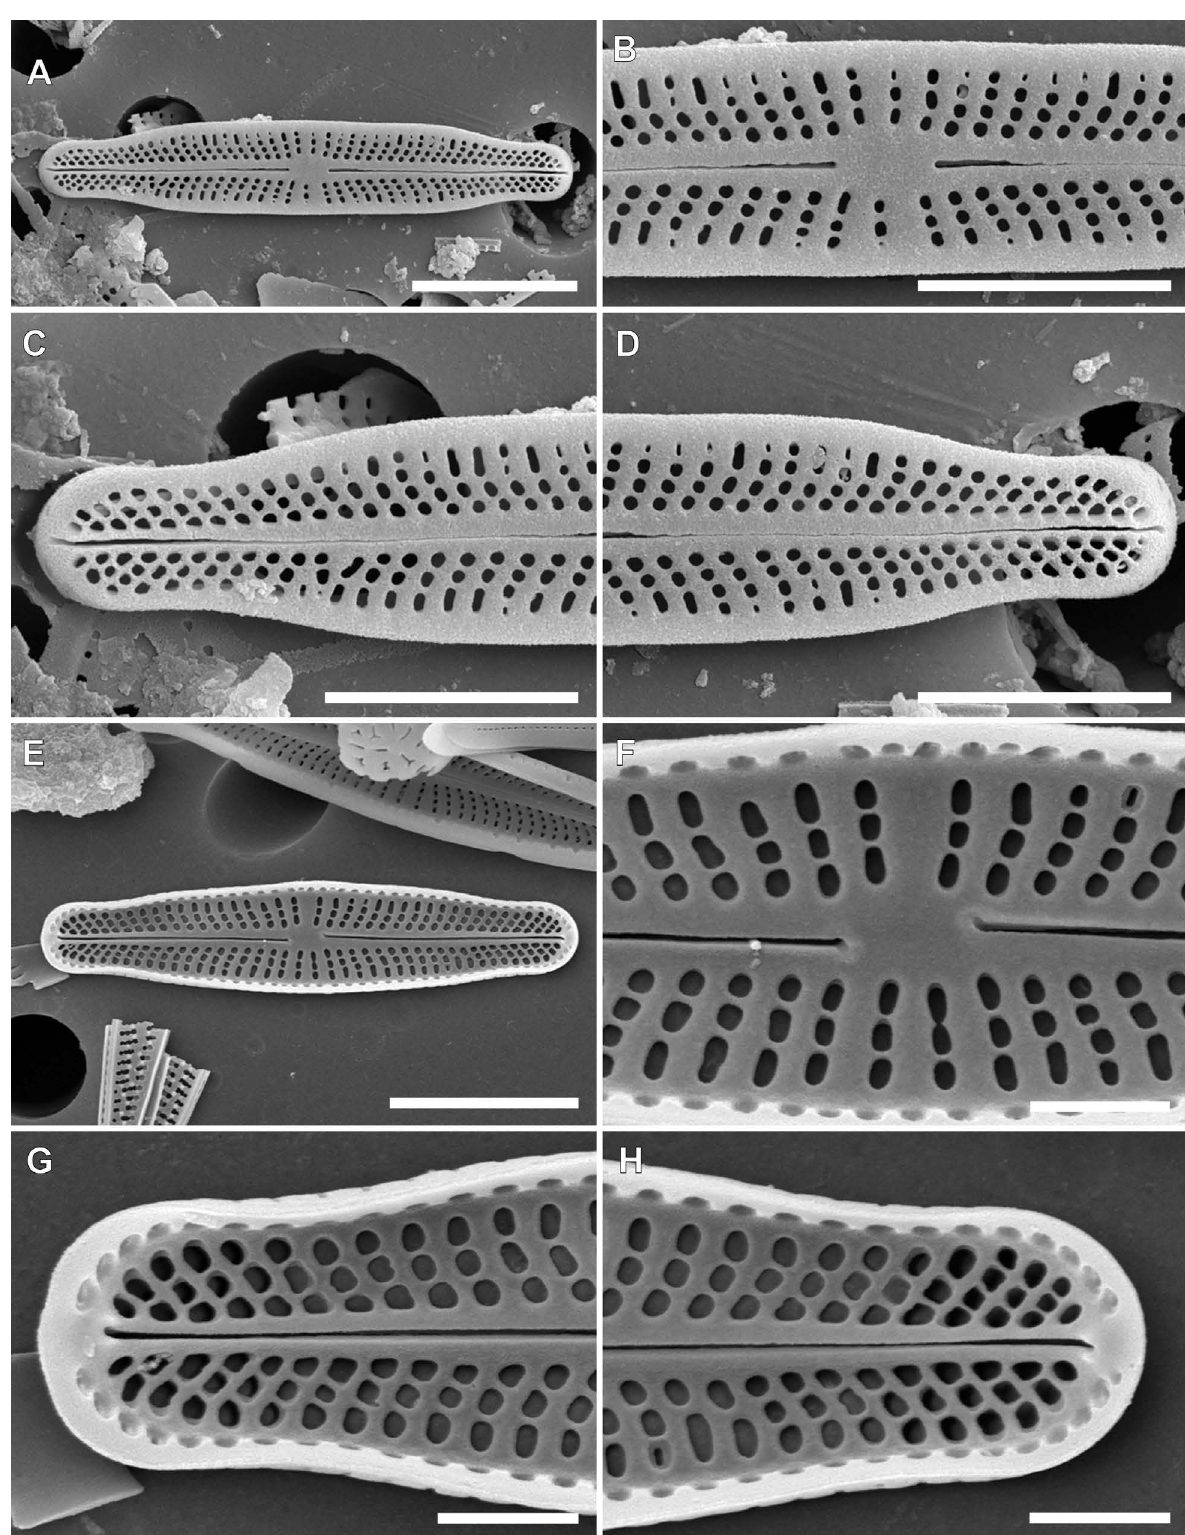
Figure 3. Achnanthidium barlasii sp. nov., SEM micrographs. A . General external valve view of a raphe valve. B . Details of central area. C, D . Details of apices. E . General internal valve view of a raphe valve. F . Details of central area. G , H . Details of apices. Scale bars 5 µm (A, E), 3 µm (B–D), 1 µm